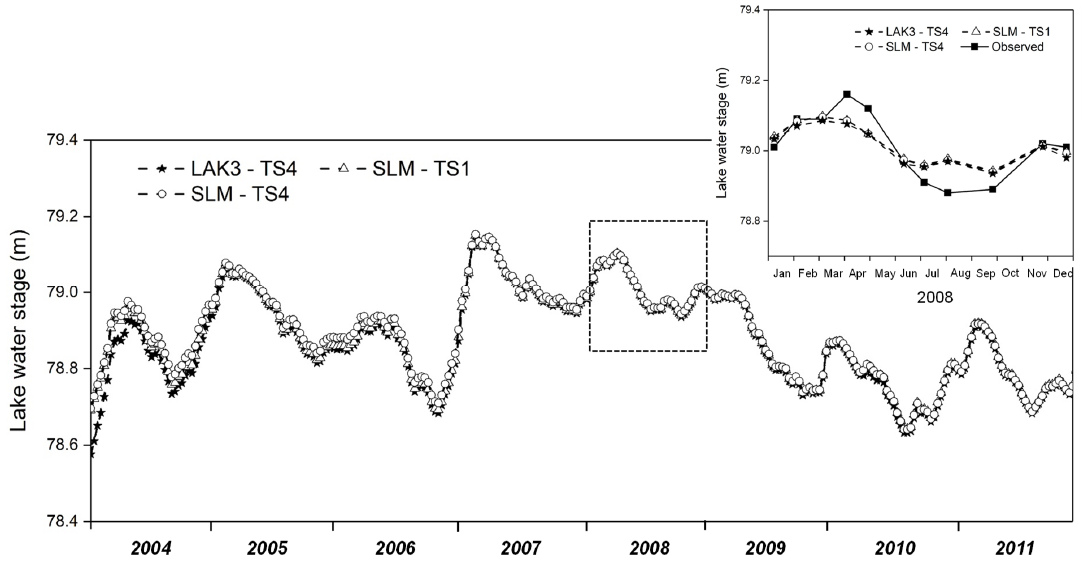
Figure 7. Comparison of observed and simulated lake level.